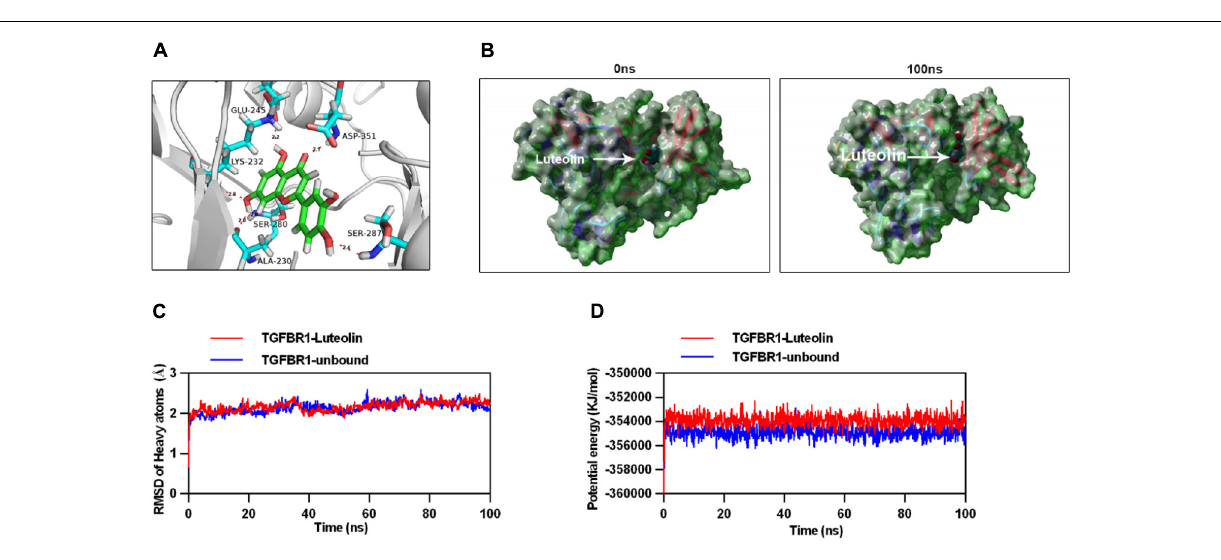
Smad3 was increased and the proliferation of VSMC was further enhanced. These results strongly indicate that luteolin performs its inhibitory function on Akt in a TGFBR1-independent manner. Inhibition of TGFBR1 signaling plays a more important role in the inhibitory actions of luteolin than suppression of